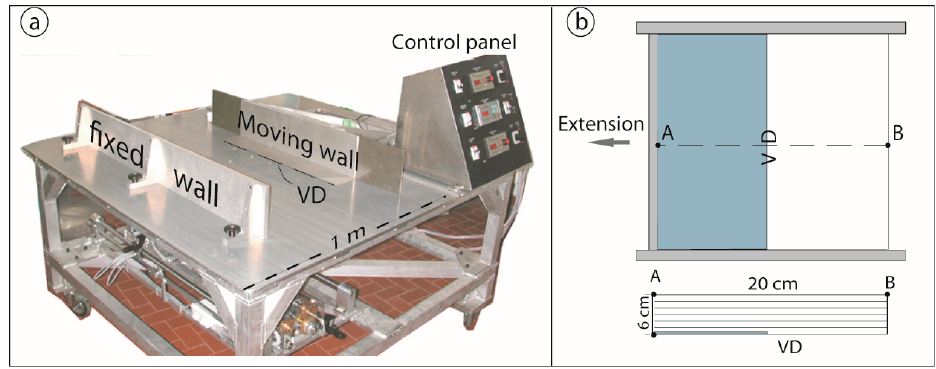
Figure 3. ( a ) Deformation pure-simple shear apparatus (‘Tosi machine’, modified after Montanari et al. [46]); and ( b ) basic model set-up used to evaluate the angle of internal friction.